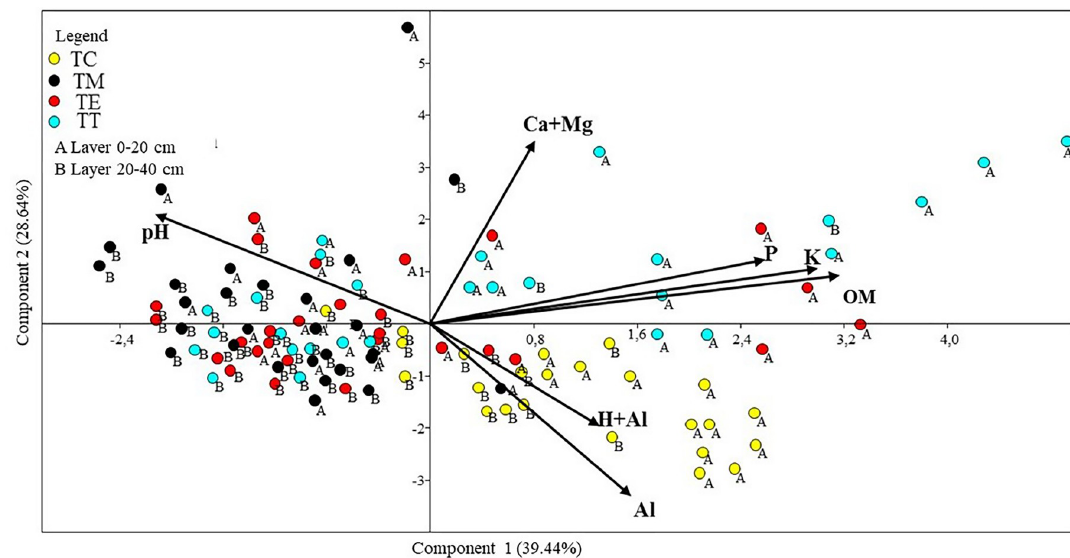
Fig 3. Chemical variables diagram. TC = samples taken from the soil under the Cerrado; TM = samples taken from the pit substrate where seedlings did not survive; TE = samples taken from the substrate of the C . pachystachya pits; TT = samples taken from the substrate of the T . guianensis